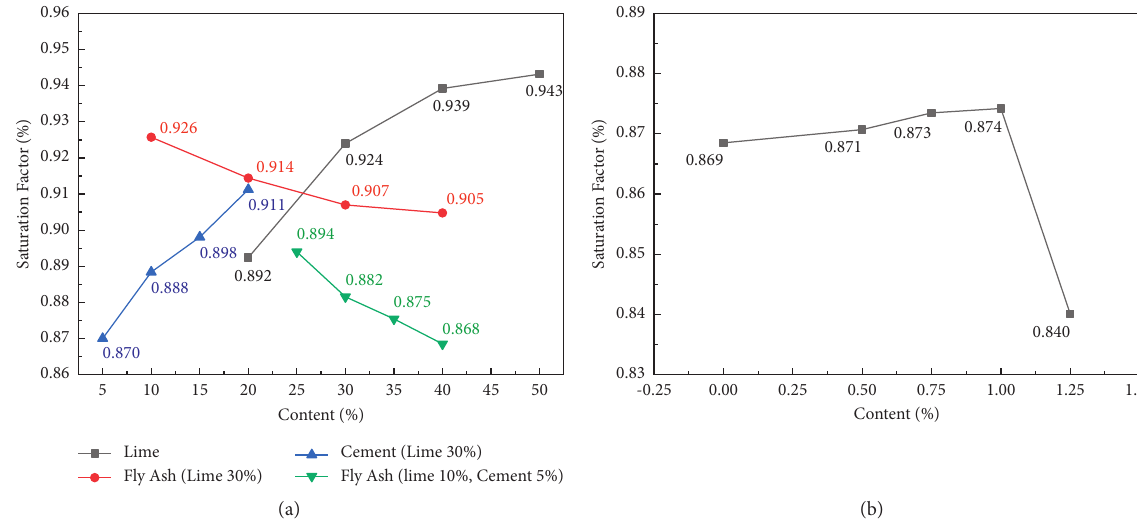
Figure 5: The influence of lime, fly ash, cement (a), and polyvinyl alcohol (lime 10%, cement 5%, and fly ash 40%) (b) on saturation coefficient.